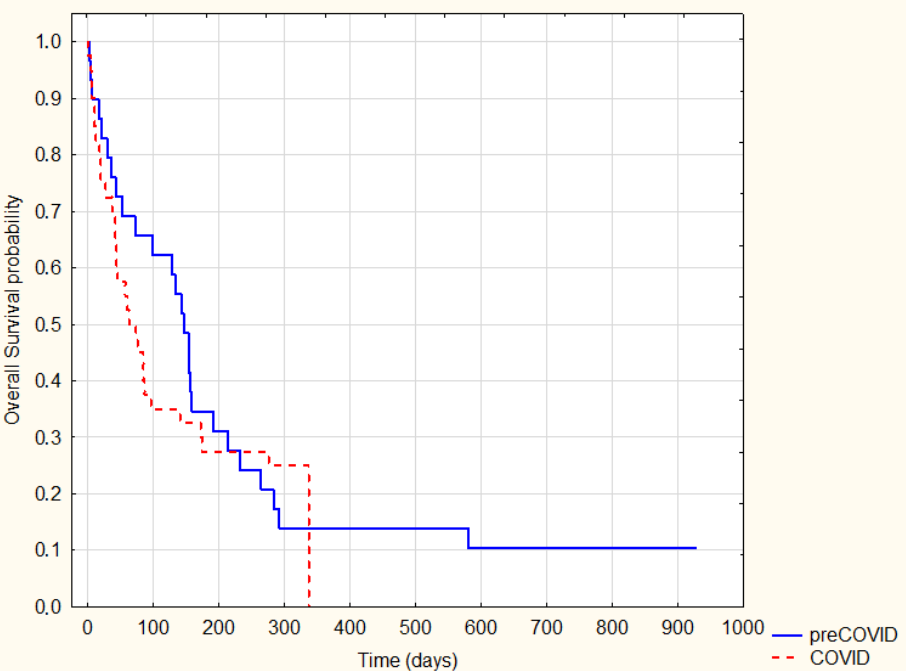
Figure 8. Kaplan–Meier Survival Analysis—small cell lung cancer pre-COVID-19 vs. COVID-19, log-rank p = 0.71.